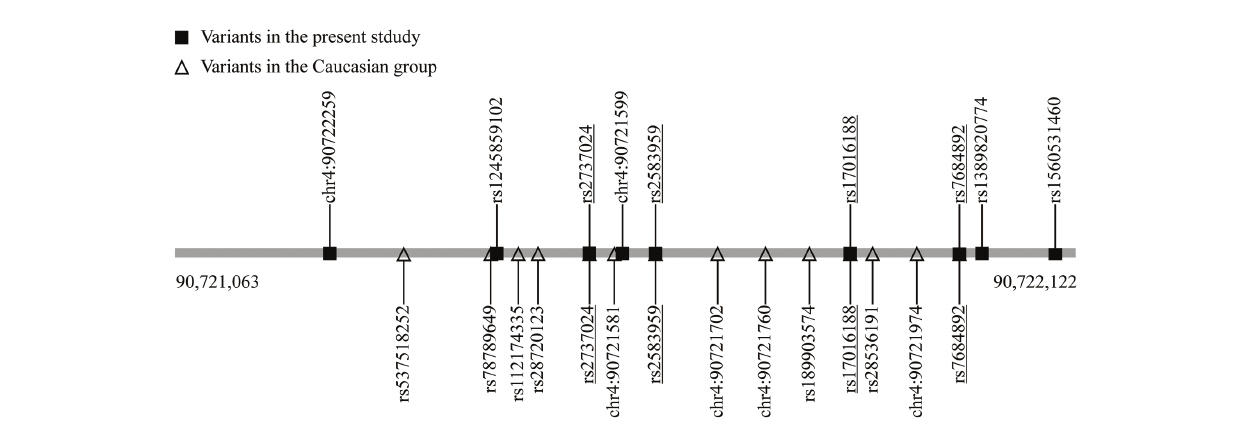
FIGURE 2 | The variants in the SNCA intron 4 CRE. The underlined are the shared